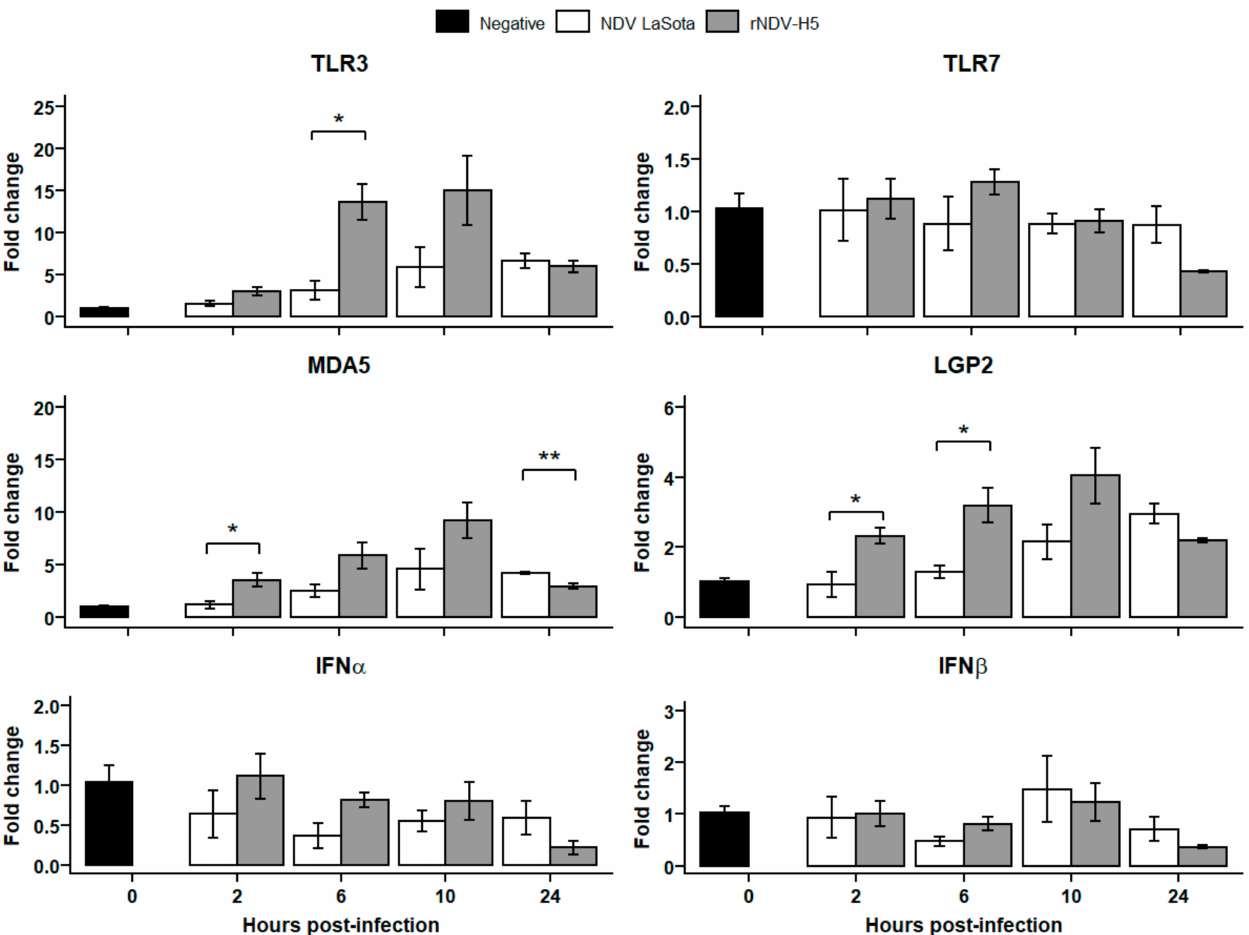
Figure 4. PRRs and type-I IFNs expression in NDV LaSota- and rNDV-H5-infected TOCs. Relative expression of TLR3, TLR7, MDA5, LGP2, IFN α , and IFN β was determined in TOCs infected with NDV LaSota and rNDV-H5 (MOI = 1) at 2, 6, 10, and 24 hpi. The data were normalized to HMBS and RPLP0 expression, calculated according to the 2 − ∆∆ CT method, and presented ± standard error of the mean. * p < 0.05, ** p <